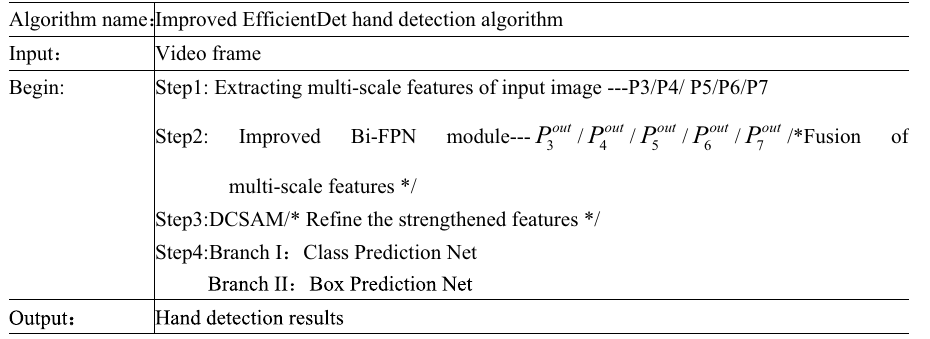
Algorithm name (cid:726) Improved EfficientDet hand detection algorithm